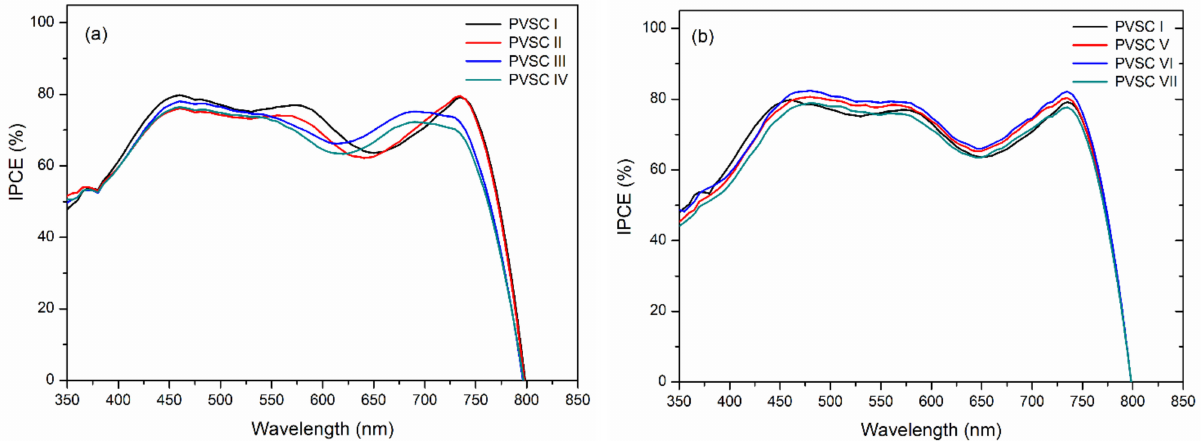
Figure 11. EQE (external quantum efficiency) spectra of PVSCs incorporating films of BCP, BCP/PMMA, and BCP/PVP films (( a ) BCP (PVSC I), BCP/PMMA (PVSC II-IV); ( b ) BCP/PVP (PVSC V-VII)), recorded under monochromatic